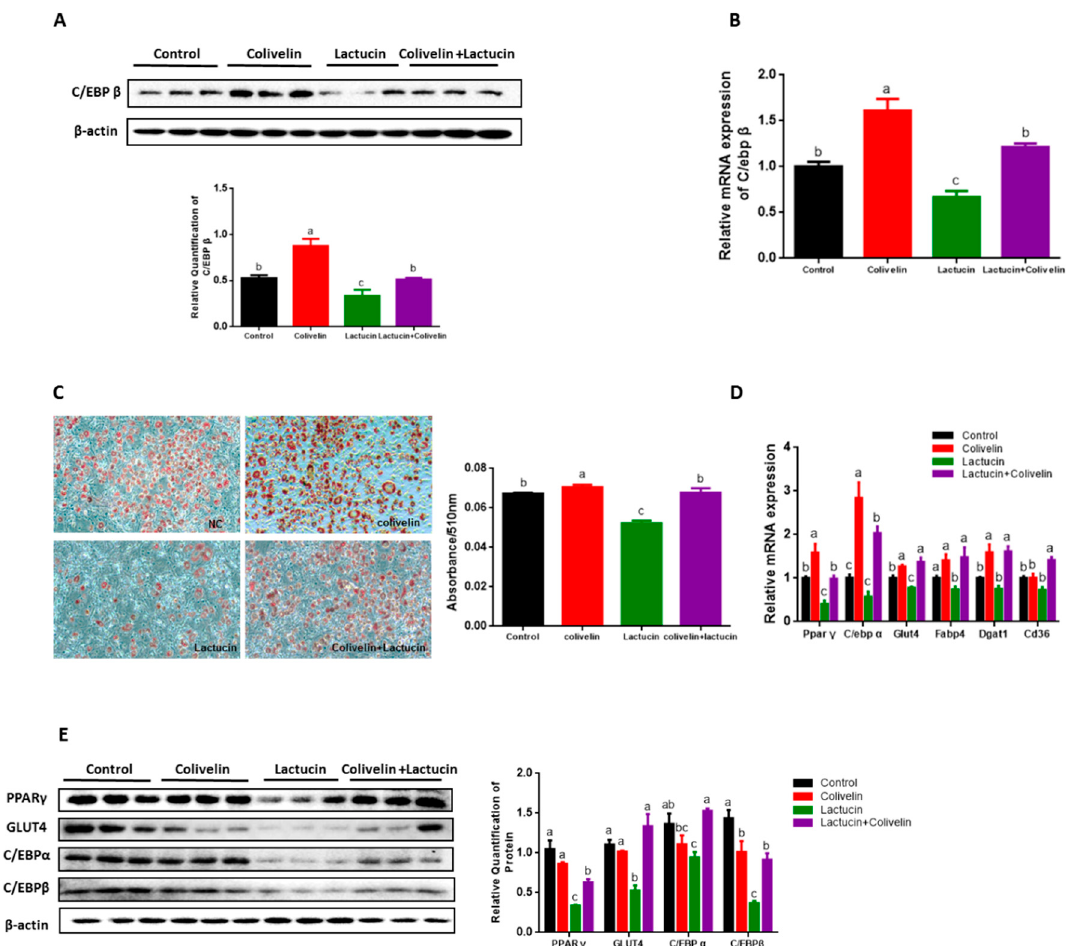
Figure 6. The pharmacological STAT3 activator reverses the anti-adipogenic effect of lactucin on 3T3-L1 cells. ( A ) The immunoblot analysis of C/EBP β in 3T3-L1 adipocytes after treatment ( n = 3). ( B ) The mRNA level of C/ebp β in 3T3-L1 adipocytes after treatment ( n = 3). ( C ) Oil Red O staining of 3T3-L1 adipocytes photographed using a microscope (×100). Lipid droplets were stained in red. And absorbance of extracted ORO accumulated in lipid droplets of 3T3-L1 adipocytes was measured spectrophotometrically at 510 nm. ( D ) The mRNA levels of lipid metabolism genes in 3T3-L1 adipocytes after treatment ( n = 3). ( E ) The immunoblot analysis of lipid metabolism genes in 3T3-L1 adipocytes after treatment ( n = 3). Data expressed as mean ± SEM. Statistics were analyzed by ANOVA (Tukey multiple comparisons test), similar letters (a, b, c) indicate an absence of significant differences.